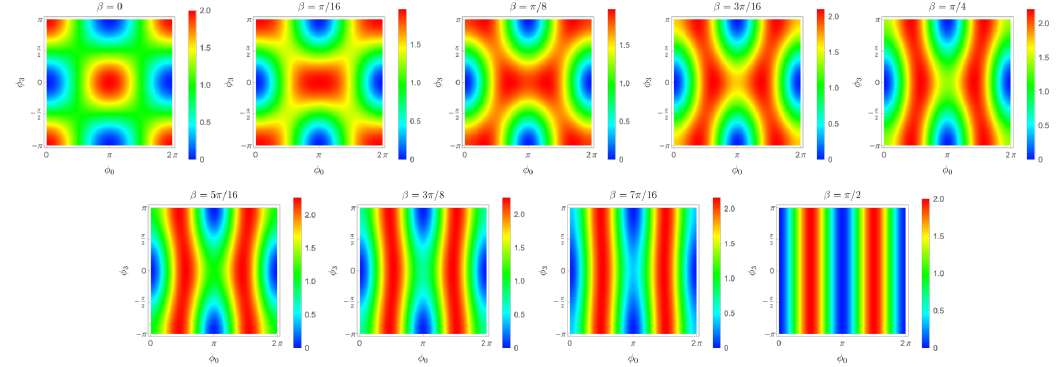
Figure 4 . The scalar potential V ( φ 0 , φ 3 ; β ) in the φ 0 - φ 3 plane ( φ 0 ∈ [0 , 2 π ] and φ 3 ∈ [ − π, π ] ) for β = 0 , π/ 16 , · · · , π/ 2 . The colors show the potential hight as indicated by the color bars. with d = 1 Tr [ λ { λ , λ } ] (a = 0, 1, 2, 3), and at the rightmost equality, µ a c abc b 2